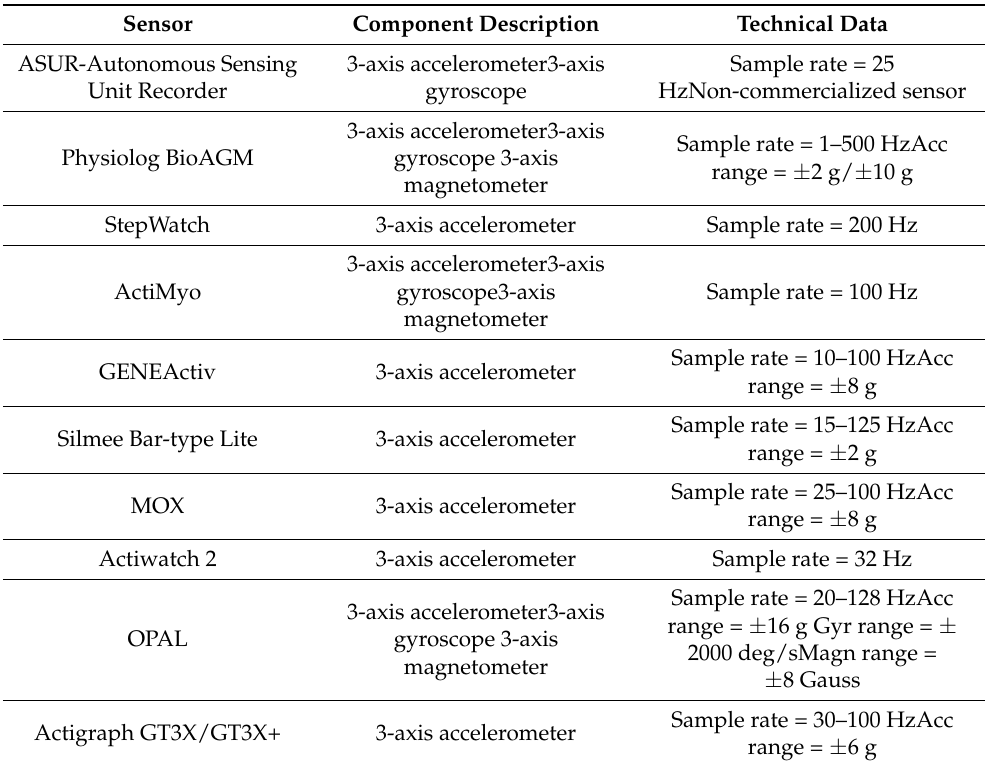
Table 2. Description of wearable sensors used in the